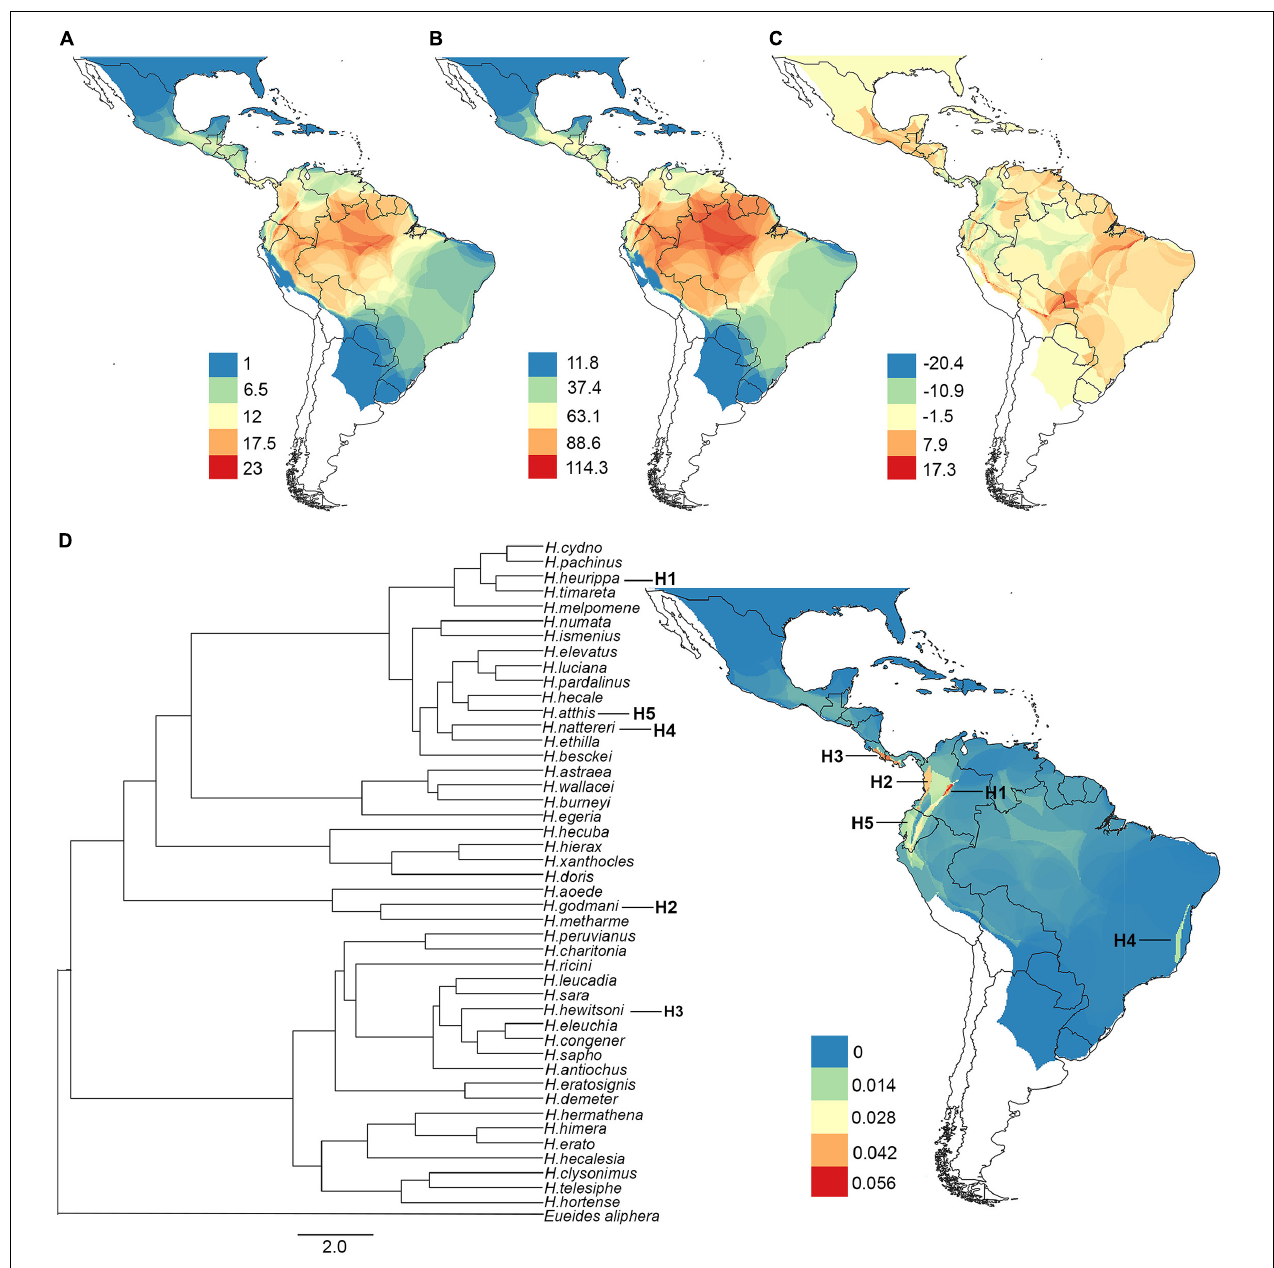
FIGURE 2 | Maps of diversity metrics. (A) Species richness, (B) phylogenetic diversity, (C) residuals of phylogenetic diversity regressed on species richness, and (D) phylogenetic endemism. Warm colors indicate higher values, while cold colors are indicative of lower values. The phylogeny shown in panel (D) was modified from Kozak et al. (2015), and branches that contribute the most to the phylogenetic endemism are labeled as H1–H5, both in the phylogeny and the map. All maps were plotted in grid cells of 20 km × 20